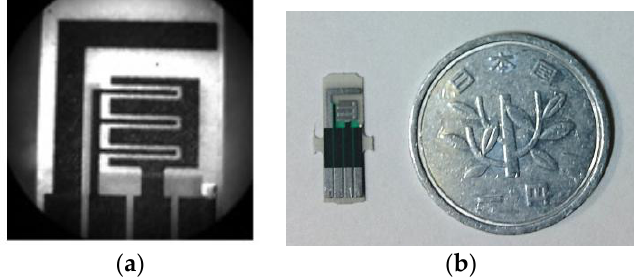
Figure 1. ( a ) Bright field image of 3 comb-shaped screen printed electrode; ( b ) Size comparison of screen printed electrode with 1 yen coin.